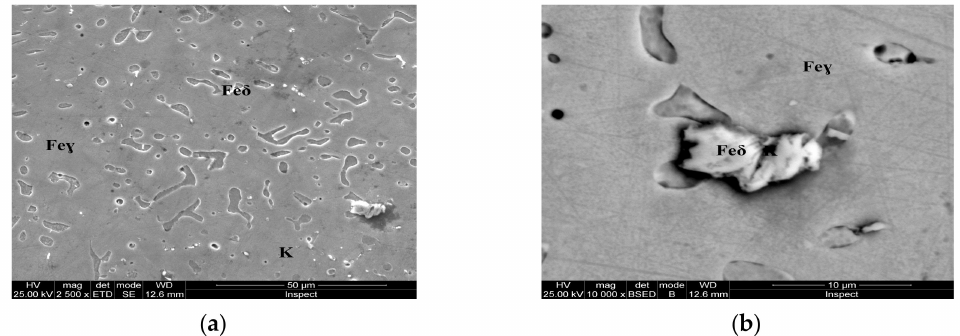
Figure 8. Microstructure of the AISI 316 modified stainless steel sample, heat-treated (Sample D): ( a ) Fe γ base matrix, Fe δ phase and small carbides (K) × 2500; ( b ) detail of the Fe δ phase surrounded by larger carbides, × 10,000.